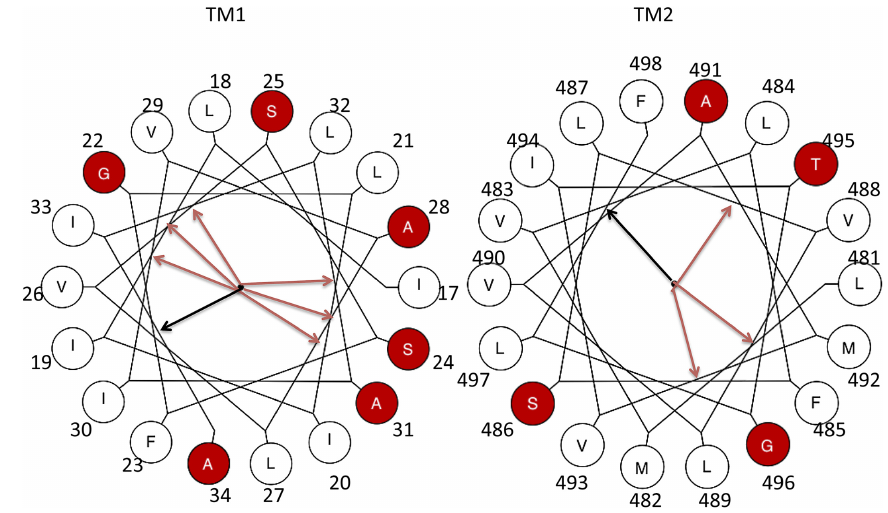
Figure 3 . Helical wheel projections of TM1 and TM2 of CD39 using the program of Kael Fisher (http://kael.net/helical.htm). TM1, start- ing at A34, and TM2, starting at L481, are shown going from the extracellular surface to the cytoplasmic surface of the plasma mem- brane. The residues colored red have helix packing values larger than that of Gln (38). The black arrow indicates the direction of the hydrophobic moment (37); the red arrows show residues with helix packing moments greater than that of Gln suggesting helical pack- ing interfaces